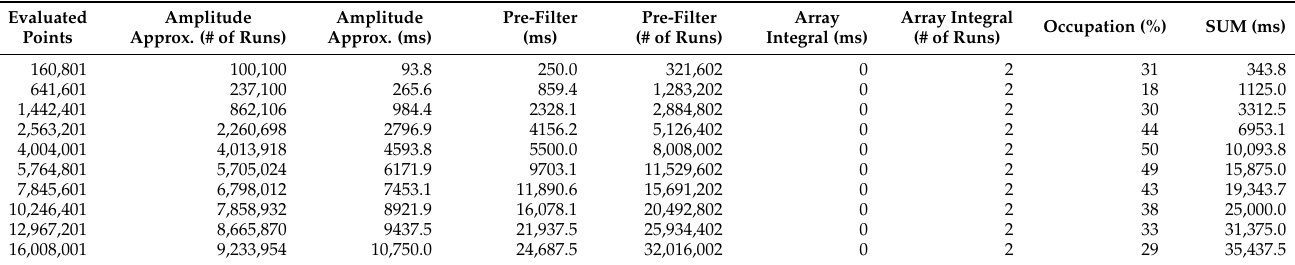
Table A4. Measurement results with pre-filtering with 2 receivers.